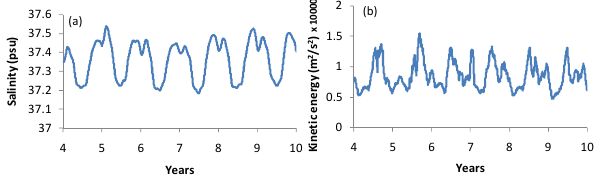
Fig. 4. Domain averaged time series of (a) the surface salinity and (b) the kinetic energy.